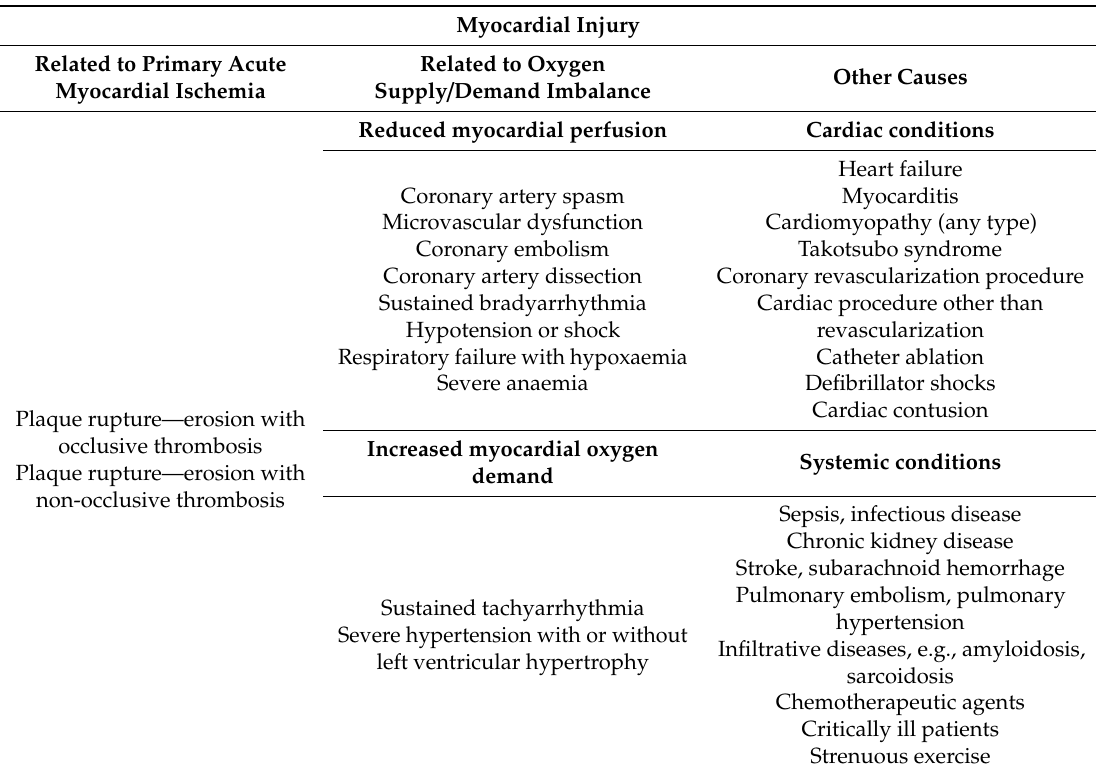
Table 1. Mechanisms of myocardial injury. Adapted from Thygesen et al. Fourth universal definition of myocardial infarction (2018)